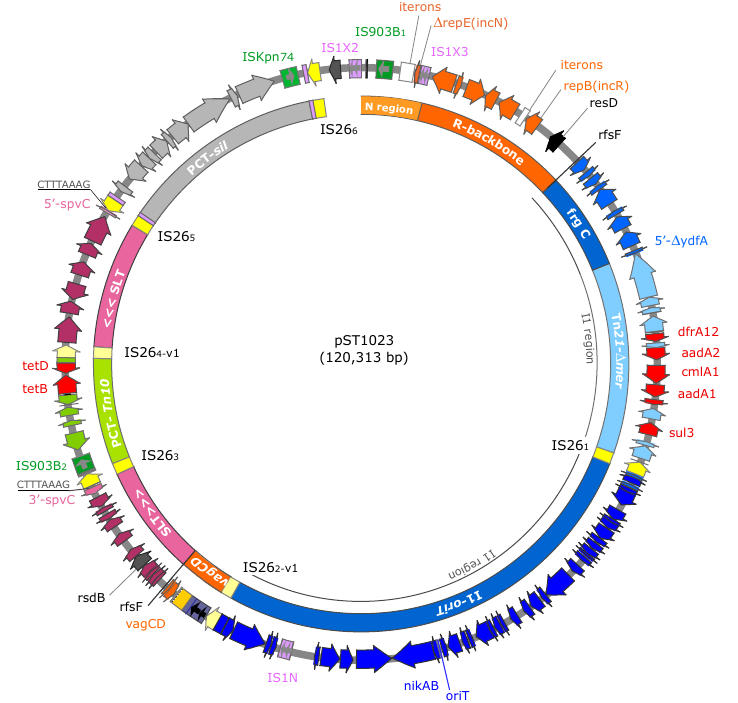
Figure 1. Physical map of pST1023. Outer ring: selected annotated open reading frames, IS elements and specific loci are shown. Arrows indicate the 5 ′ to 3 ′ transcription direction. Inner ring: the different regions that constitute the mosaic pST1023 are shown with coloured boxes: IncR backbone (red orange), Fragment C and I1- oriT (blue), SLT (dark terracotta), Tn 21 - Δ mer (light blue), PCT-Tn 10 (apple green) and PCT- sil (grey). IS 26 (yellow) and IS 903B (green) are numbered. The IncR backbone included repB (that encodes the replication initiation protein RepB) and its iterons (composed of 36 bp present in 10,4 copies), parAB (a partition system encoding the ATPase protein ParA and the centromere-binding protein ParB), umuCD (that encodes an error-prone DNA polymerase V, a key contributor in the SOS response), retA (a group IIB intron-encoding reverse transcriptase), rfsF - resD (site-specific recombi- nation system) and vagCD (encoding a type II toxin–antitoxin (TA) system, consisting of VagC antitoxin and VagD toxin) [10,30]. vagCD was inversely oriented and separated from rfsF by region I1 (57,754 bp). Region I1 was composed of a remnant of fragment C (7.1 Kb, see below), a Tn 21 - Δ mer (14.6 Kb) and a 32.5 Kb fragment (called I1- oriT ); the last was linked to sequences from the leading region and part of the conjugative region of IncI1 plasmids [31]. The fragment C has mainly been identified in IncI1 plasmids, some of which had a Tn 21 -derived transposon (like the Tn 21 - Δ mer but retaining the mer operon) inserted into ydfA [17]. The Tn 21 - Δ mer also mapped next to 5 ′ - Δ ydfA and was composed of tnpA (transposase), tnpR (resolvase), tnpM (interrupted by a sul3 -associated class 1 integron, carrying the array dfrA12 - orfF - aadA2 - cmlA1 - aadA1 - qacH ) and mef (interrupted by the IS 26 1 ). The fragment I1- oriT was composed of: I) the impCAB operon ( impB was inter- rupted by the IS 26 1 ) encoding (based on the homology to umuCD ) an error-prone DNA repair system [32]; II) the psiAB operon (inhibition system of the SOS response that during conjugation prevents LexA autocleavage catalysed by RecA) [33]; III) the ardA gene, en- coding an anti-restriction and anti-modification protein that prevents cleavage at foreign DNA entering a new bacteria host [34]; IV) the relaxation complex, composed of the oriT sequence (origin of transfer) and the nikAB gene cluster (encoding the oriT -specific DNA binding protein NikA and the relaxase NikB, respectively) [31]; V) the trbABC operon es- sential for conjugational transfer of IncI1 plasmids (TrbA and TrbC are key elements in